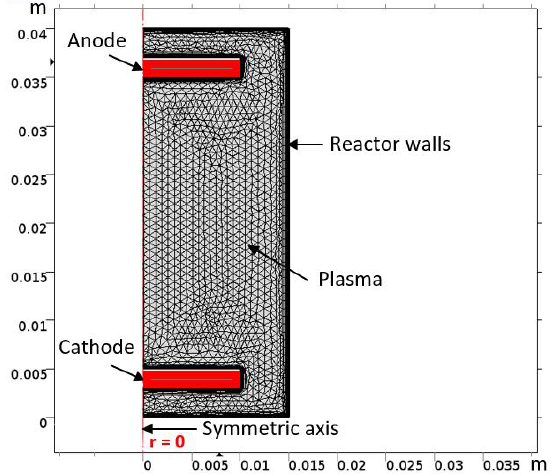
Figure 2. Computational domain.